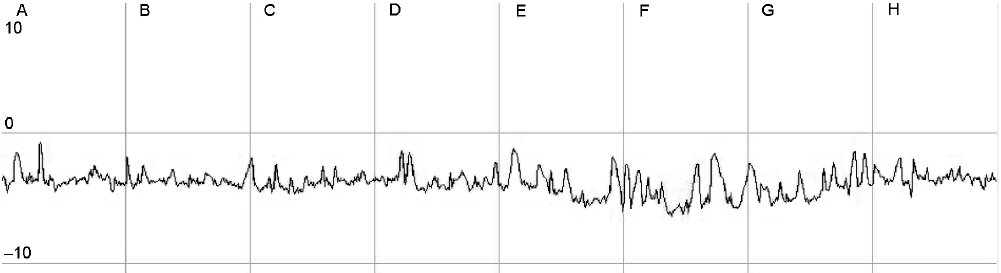
Fig. 6. Surface profile of exposed aggregate sample measured by the CT meter scanner (in mm